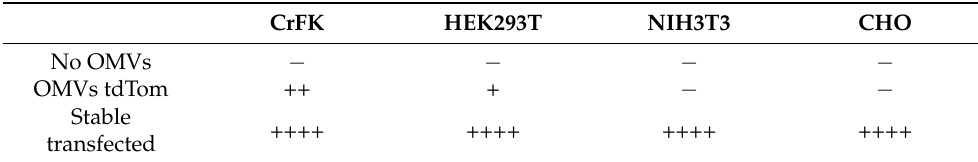
Table 2. Estimating purity of OMV preparations.